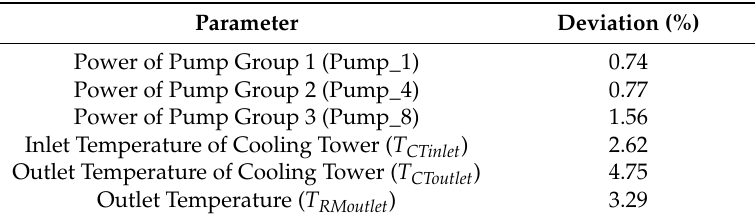
Table 4. Deviations obtained for the pumps measured power.